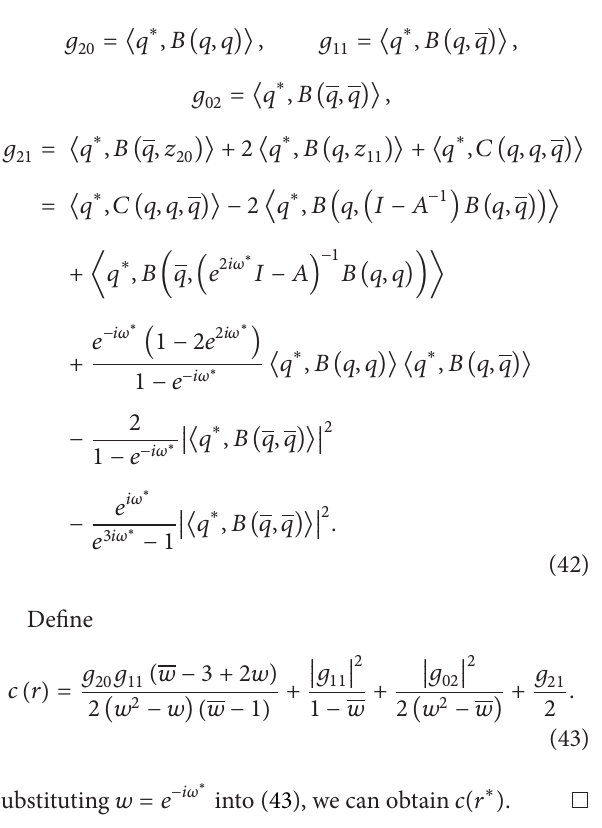
When restricting (38) to the center manifold, up to